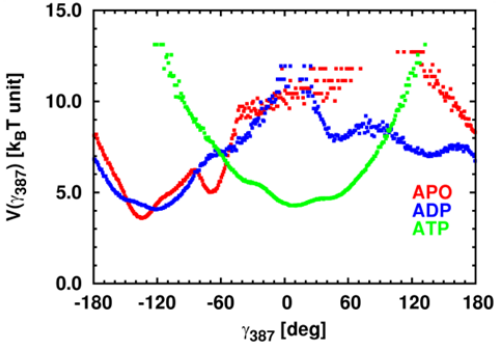
Figure 7. Overview of the 27 CGDAs c . A: NBD + linker. B: SBD. Each CGDA c i is represented by a sphere centered on the C a (i) atom. The color code of the protein structure is the same as in Fig. 1. These figures were prepared with PyMOL [http://www.pymol.org].